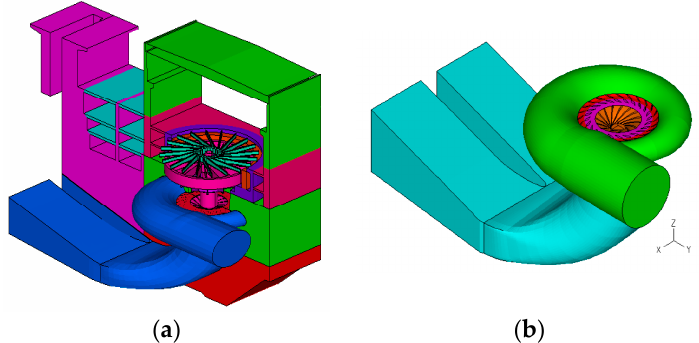
Figure 1. Computational domain. ( a ) Fluid–structure interaction (FSI) model, ( b ) fluid model.